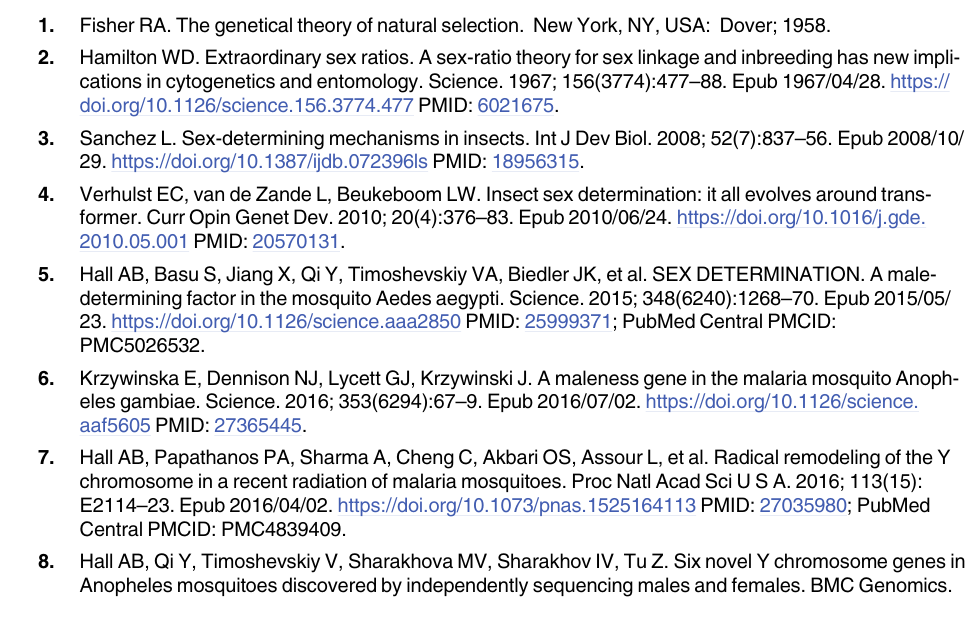
landed from each line, the black arrow indicates the position in the gene where the transgene was